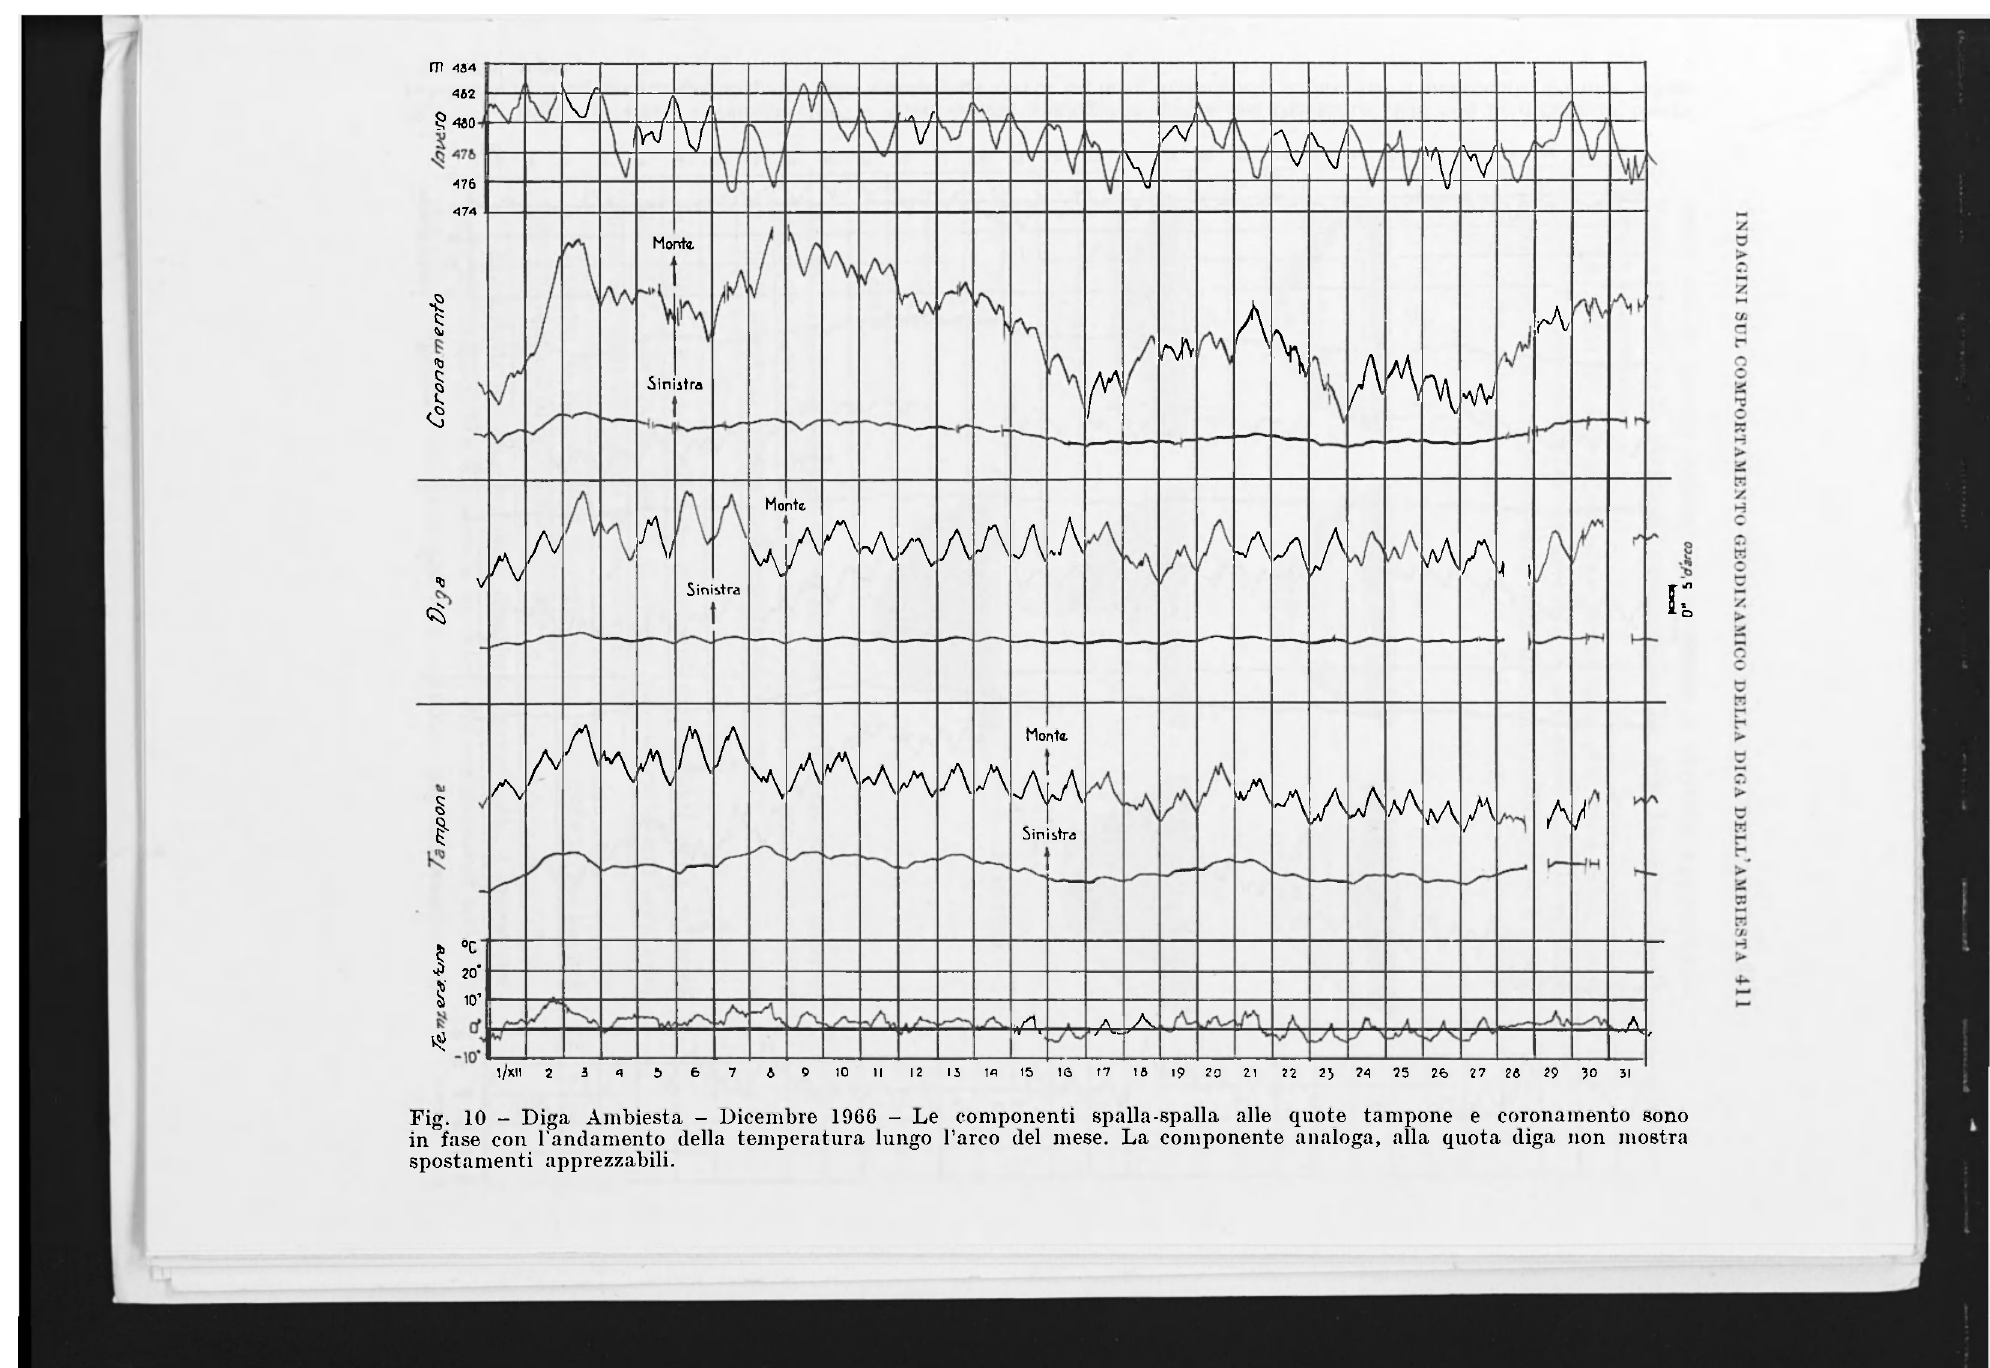
Fig. 10 - Diga Ambiesta - Dicembre 1966 - Le componenti spalla-spalla alle quote tampone e coronamento sono in fase con l'andamento della temperatura lungo l'arco del mese. La componente analoga, alla quota diga non mostra spostamenti